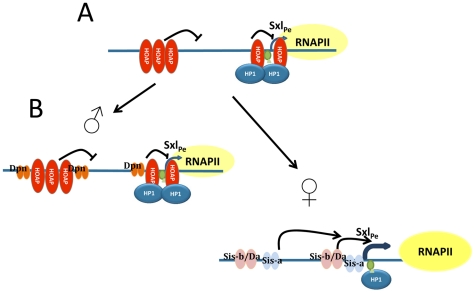
Model of the interactions between HOAP and HP1 at SxlPe.(A) Maternal HOAP and HP1 cooperate to form a repressive complex which serves to reduce the sensitivity of SxlPe to spurious fluctuations in zygotic expression of positive (e.g. Sis-a, Sis-b) and negative (e.g. Dpn) regulatory proteins. Pre-loading of RNA pol II requires HP1. (B) Binding of bHLH proteins to SxlPe sequences is dependent on their zygotic dose and binding sites relative to those for HOAP. At 2–3 hr of development, the two X chromosome dose of positive factors in females, is able to result in activation of SxlPe, and allow the pre-loaded RNA pol II to extend. In males, the single X chromosome presumably does not produce enough positive factors to displace (all of) the negative components. For simplicity not all known X∶A factors are shown. The triangle depicts low levels of H3K9 methylation at the promoter.